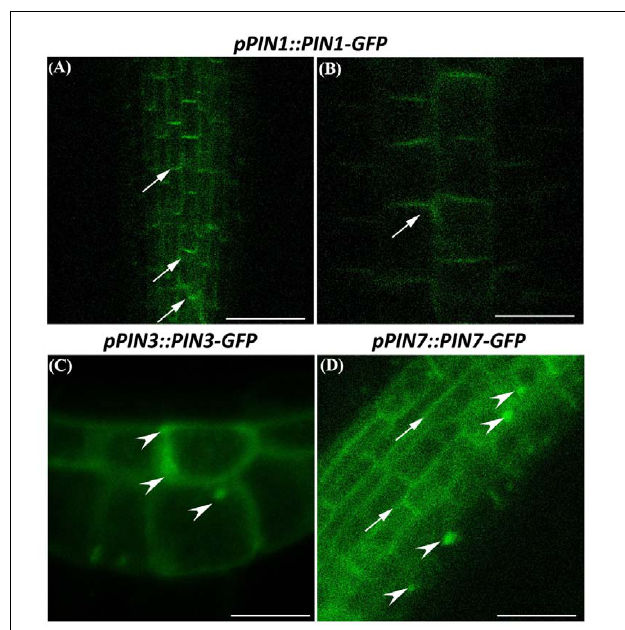
FIGURE 8 | Subcellular localization of PIN1, (A,B) , PIN3 (C) and PIN7 (D) proteins in primary root of A. thaliana seedlings germinated on growth medium as control (Ctrl); and on medium added with Cd 50 µ M for 8 DAG. Arrow on lateral localization of PIN; arrow head on PINs intracellular accumulation. Scale bars (A) 12 µ m; (B–D) 25 µ